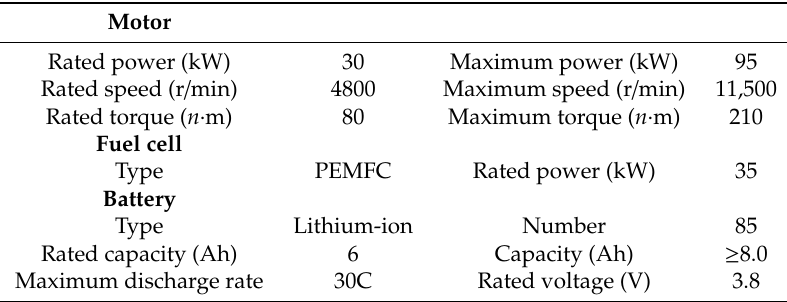
Table 2. Parameters of motor, fuel cell and